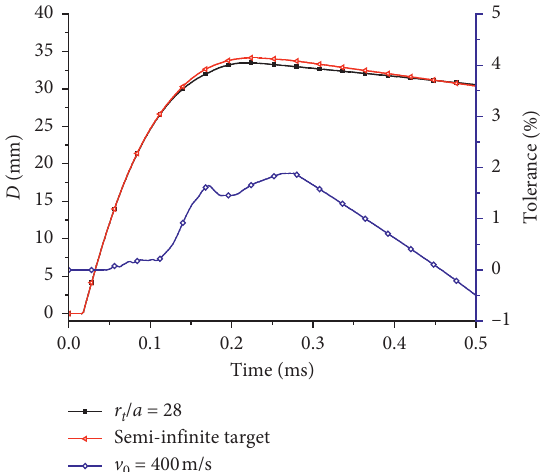
Figure 22: Deviation comparison of the penetration depth for the free boundary ( r t / a � 28) and the nonreflecting boundary ( v � 400m/s).